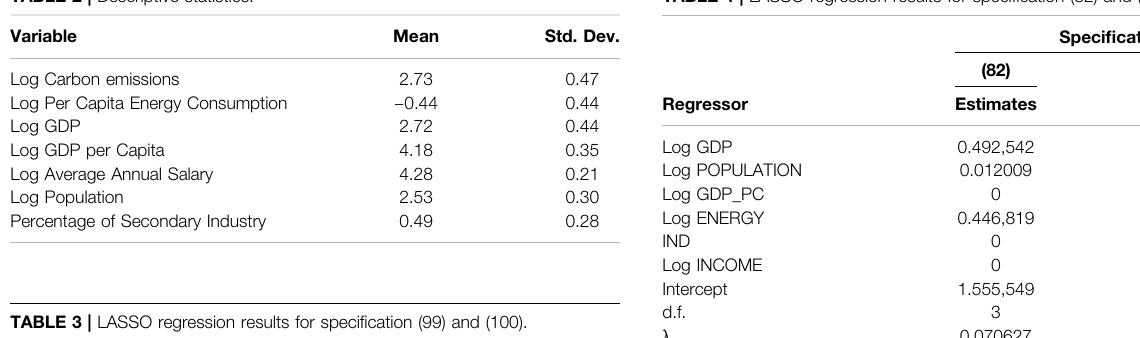
TABLE 4 | LASSO regression results for speci fi cation (82) and